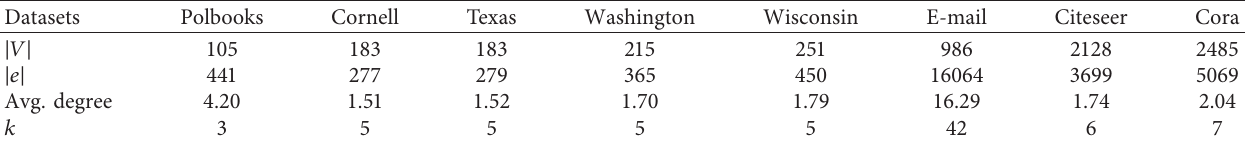
Table 2: Statistics of real-world datasets used.